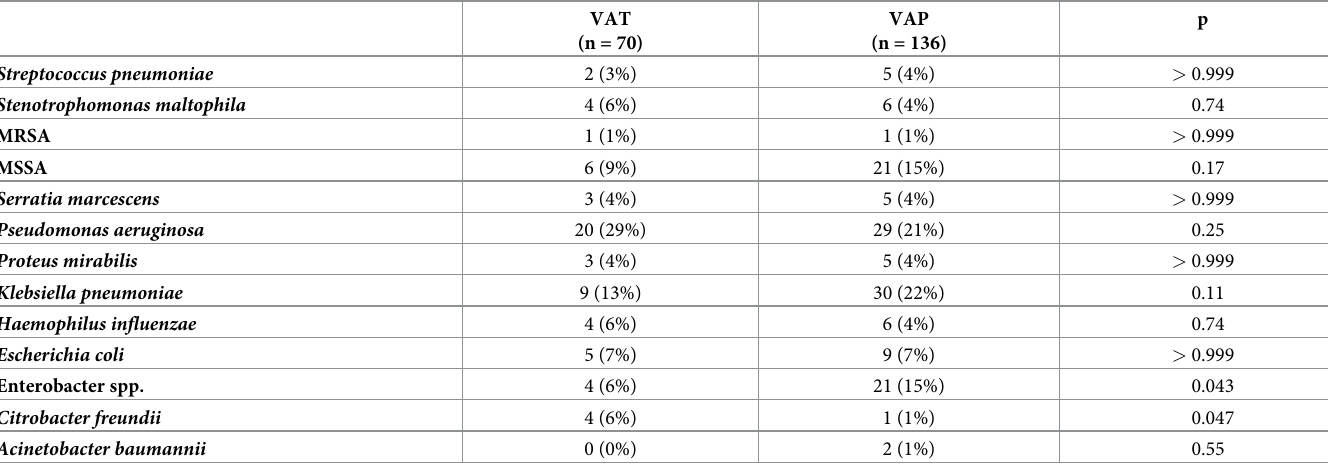
Table 2. Microbiological findings.